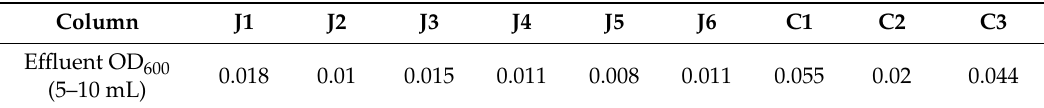
Table 7. Optical density of column e ffl uent following bacteria